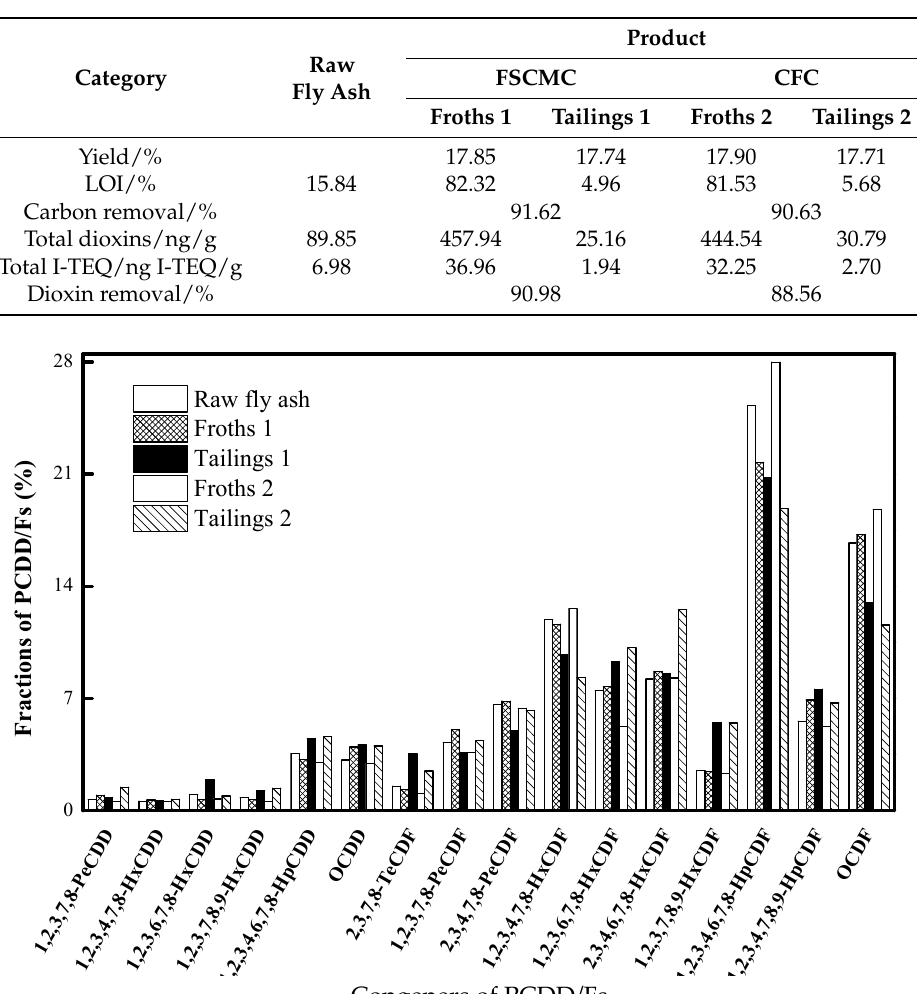
Figure 11. Fractions of each congener of polychlorinated dibenzo-p-dioxins and polychlorinated dibenzofurans PCDD/Fs in the raw fly ash, froths 1, tailings 1, froths 2, and tailings 2.